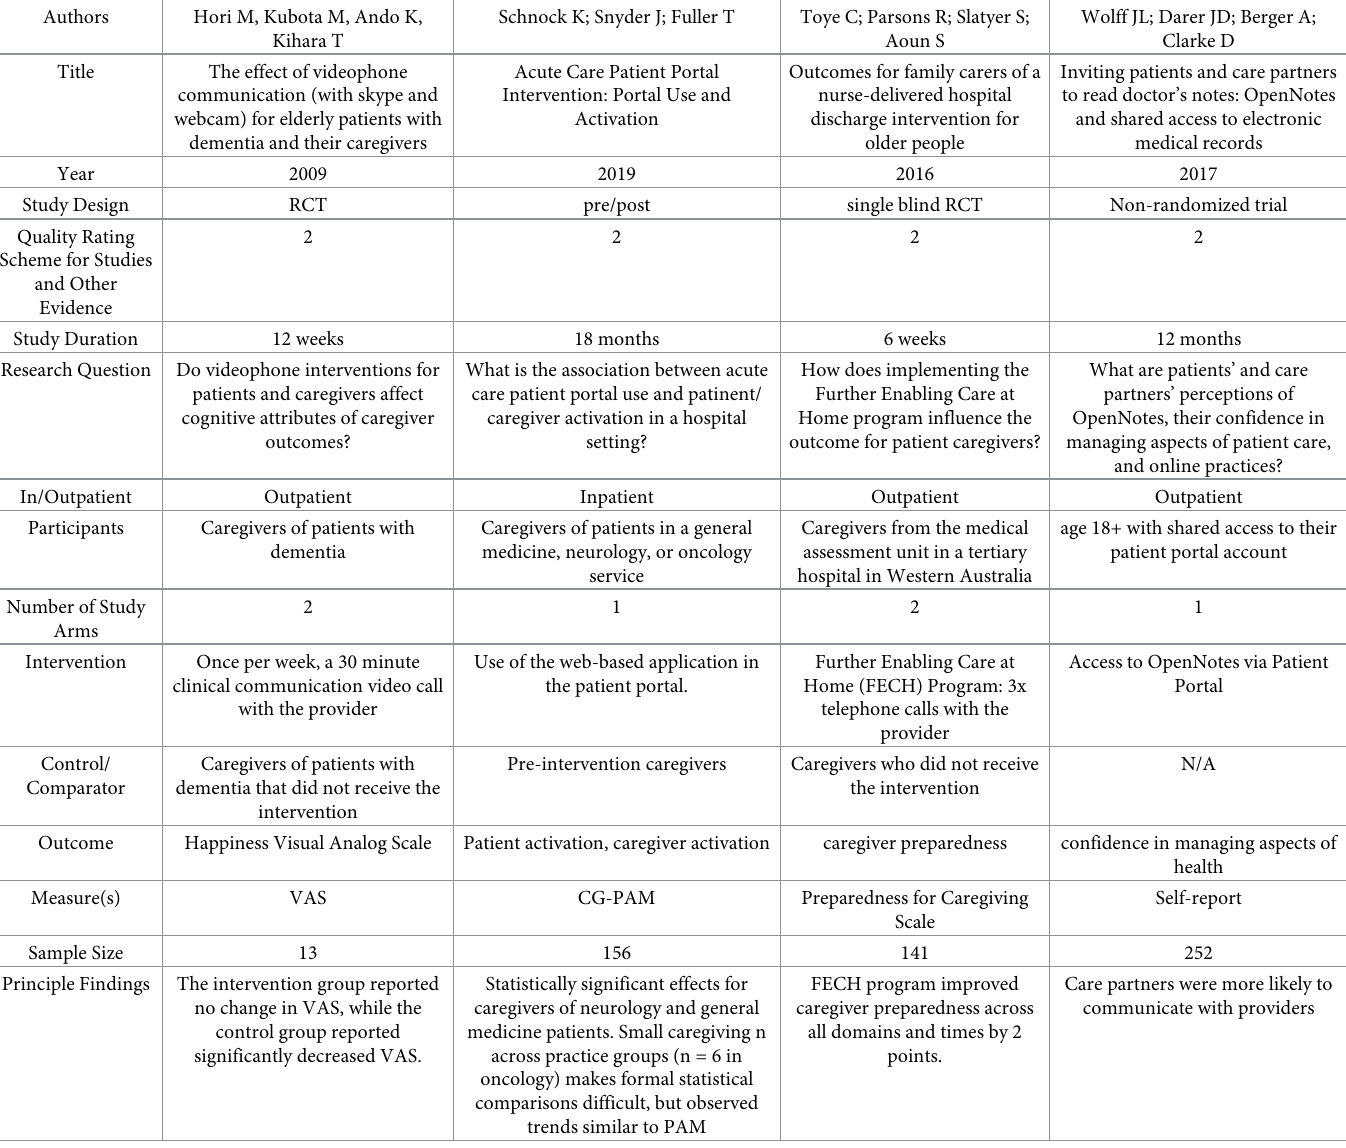
Table 1. Characteristics of included studies.